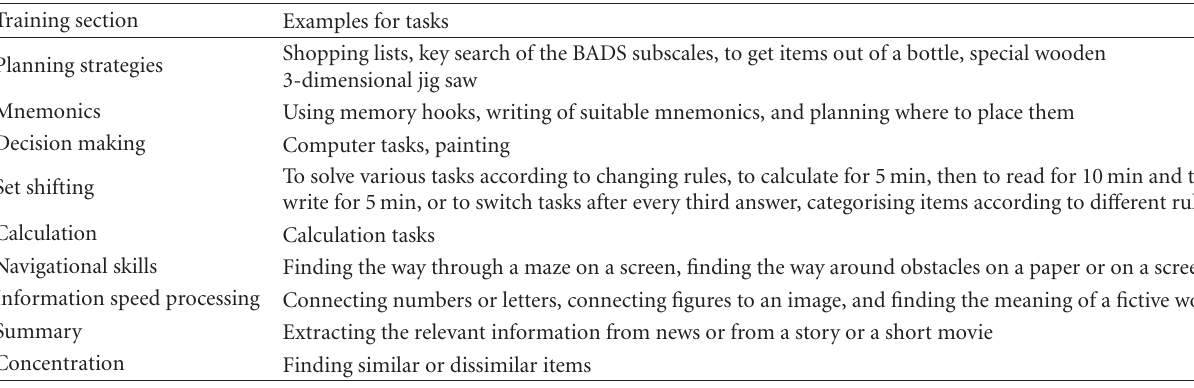
Table 1: Cognitive training.